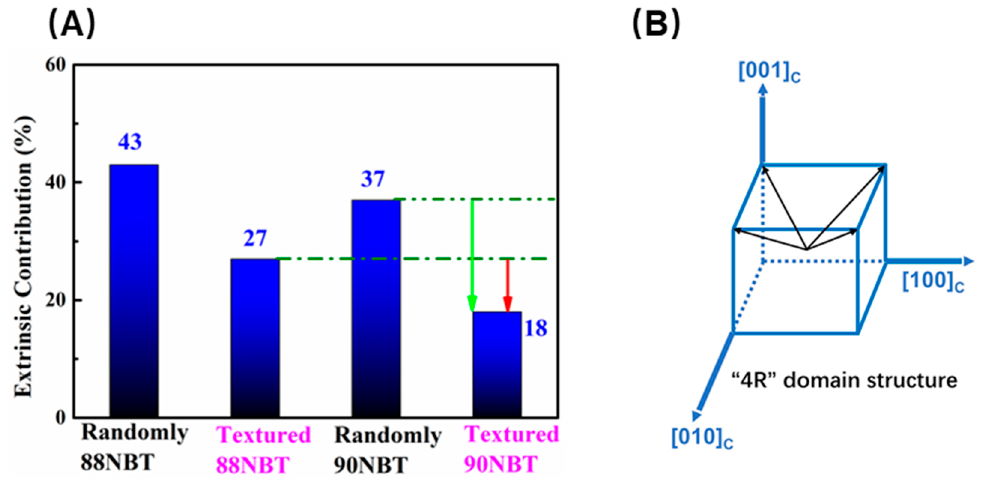
Figure 3. The d 33 as a function of ac electric field for ( A ) randomly oriented 88NBT ceramic, ( B ) textured 88NBT ceramic, ( C ) randomly oriented 90NBT ceramic, and ( D ) textured 90NBT ceramic.